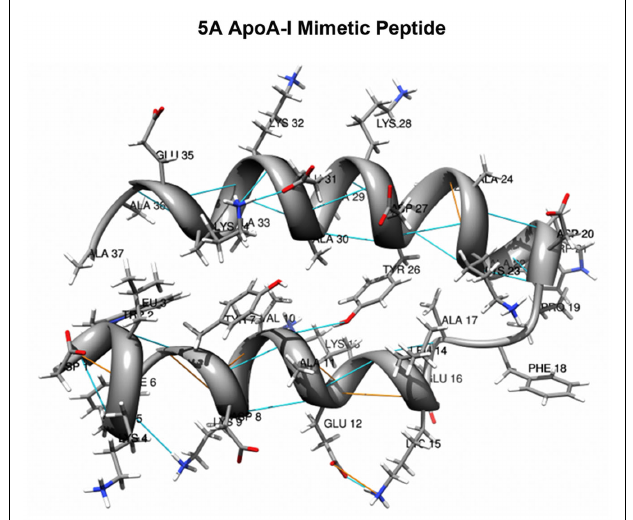
FIGURE 3 | 5AApolipoproteinA-I mimetic peptide. The 5A peptide is a 37 amino acid long bihelical peptide, containing a proline that links two amphipathic helices. 5 Alanine substitutions are made in the hydrophobic face of the second helix to reduce its lipid-binding affinity (courtesy of Alexander Andrianov, Ph.D. and adapted with permission fromYao et al.,